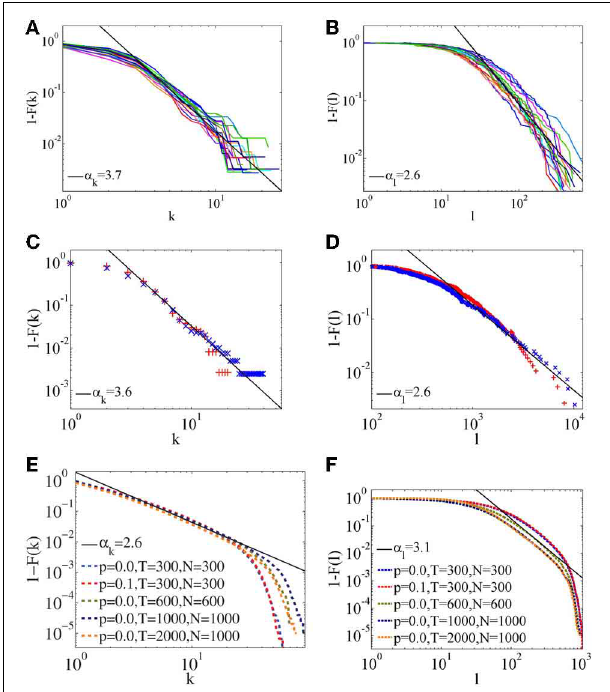
FIGURE 5 | (A,C,E) Cumulative degree distribution for networks created from SAR images, optical images and GFN model respectively. (B,D,F) Cumulative length distribution for networks created from SAR images, optical images and GFN model,